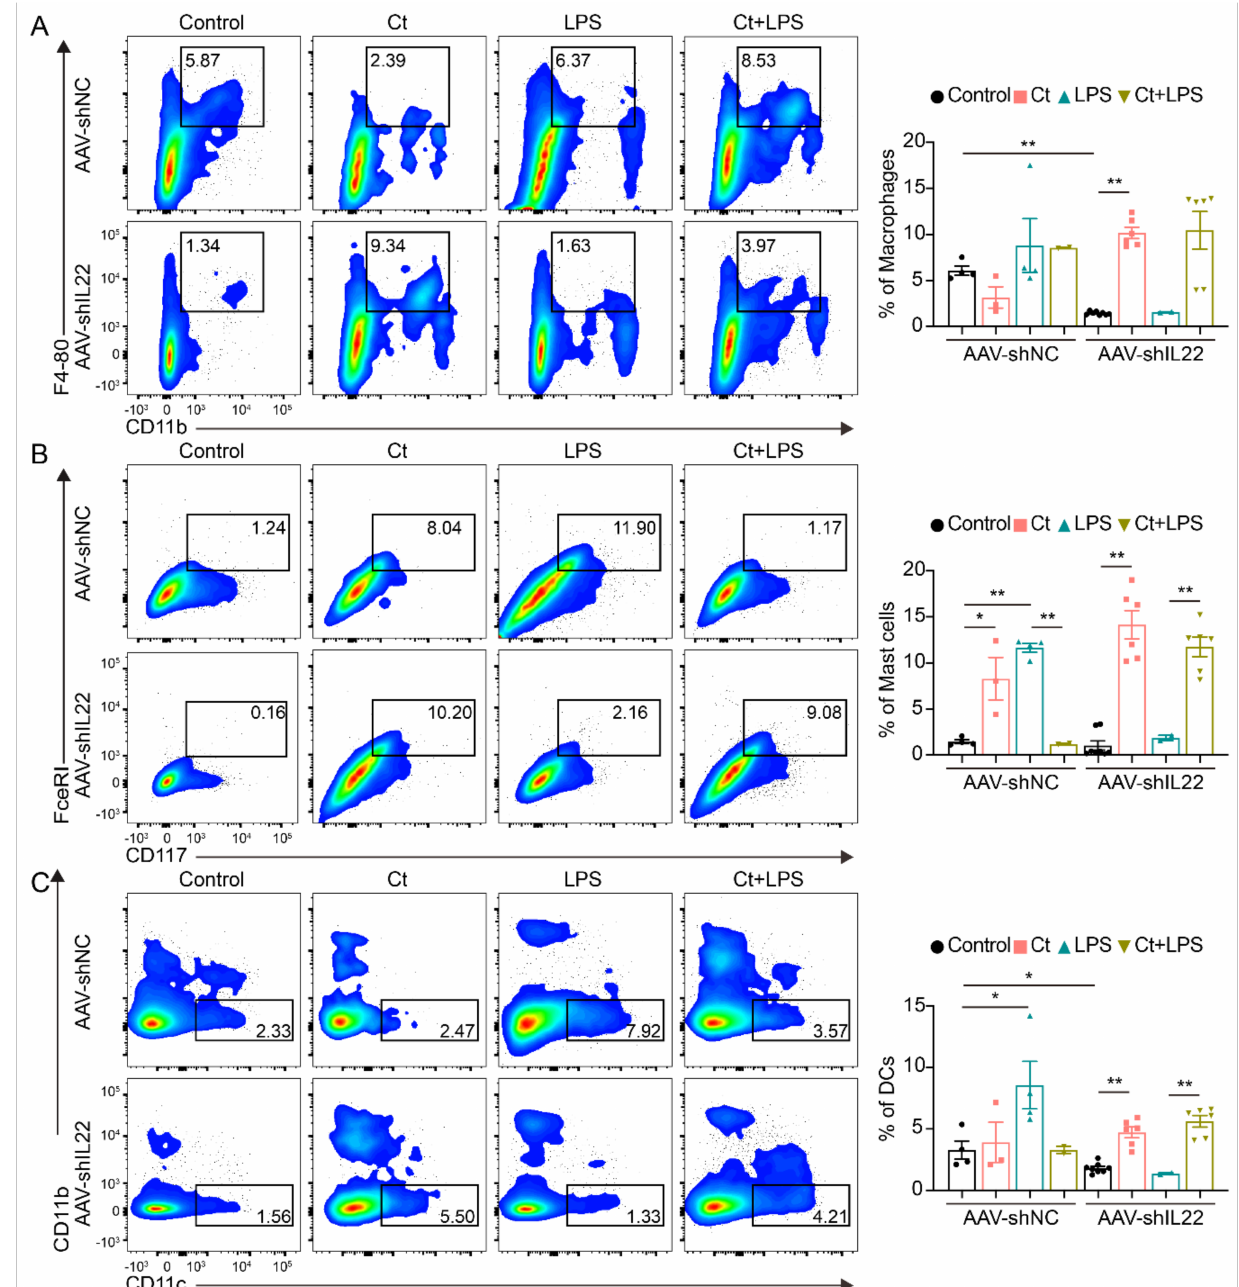
Figure 6. Effects of Ct on proportions of macrophages, mast cells, and dendritic cells (DCs) in mice knocking down IL-22. ( A ) Proportion of macrophages; ( B ) proportion of Mast cells; ( C ) proportion of DCs. Each dot presented one mouse. Data presented as mean ± SEM. * p < 0.05, ** p < 0.01 by two-way unpaired t